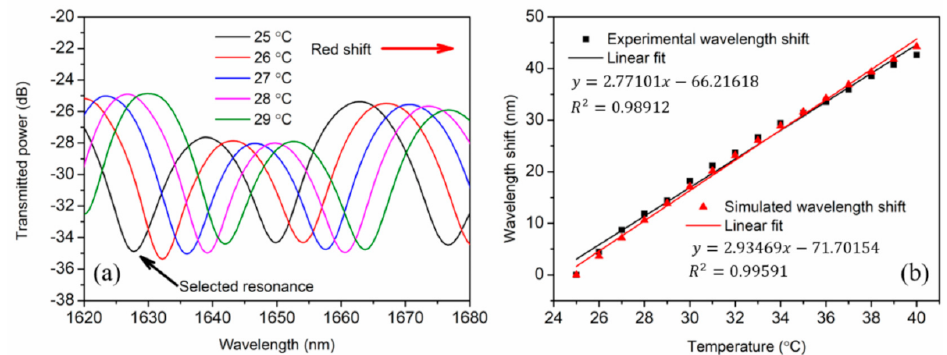
Figure 4. ( a ) Partial transmitted spectrum evolution of the sensor measured in the temperature range of 25 to 29 ◦ C. The length of the infiltrated glycerol–water solution is 15 cm; ( b ) experimental and simulated wavelength shift of the spectral dip at ~1628 nm as a function of temperature in the range of 25 to 40 ◦ C.